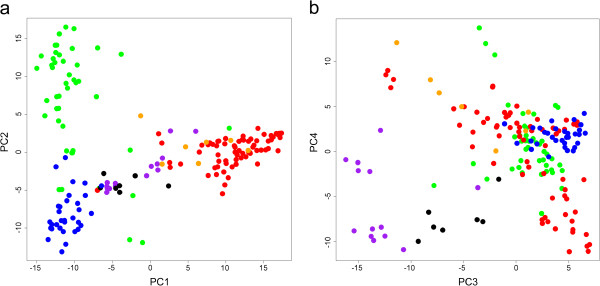
Results of Principal Component Analysis of durum wheat landrace accessions coloured and labelled by country of origin. PCA was based on the allele frequencies of 369 SNP markers.